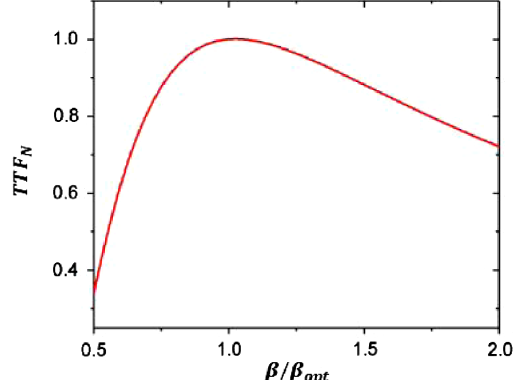
FIG. 14. Universal normalized transit time factor as a function of normalized β .